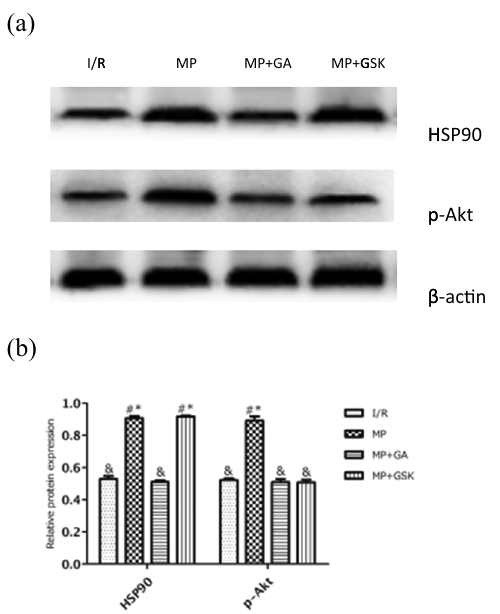
Figure 3: E ff ects of MP on HSP90 and p - Akt protein expression. ( a ) Representative Western blots showing the expressions of HSP90 and p - Akt. ( b ) Relative expression of HSP90 and p - Akt proteins.